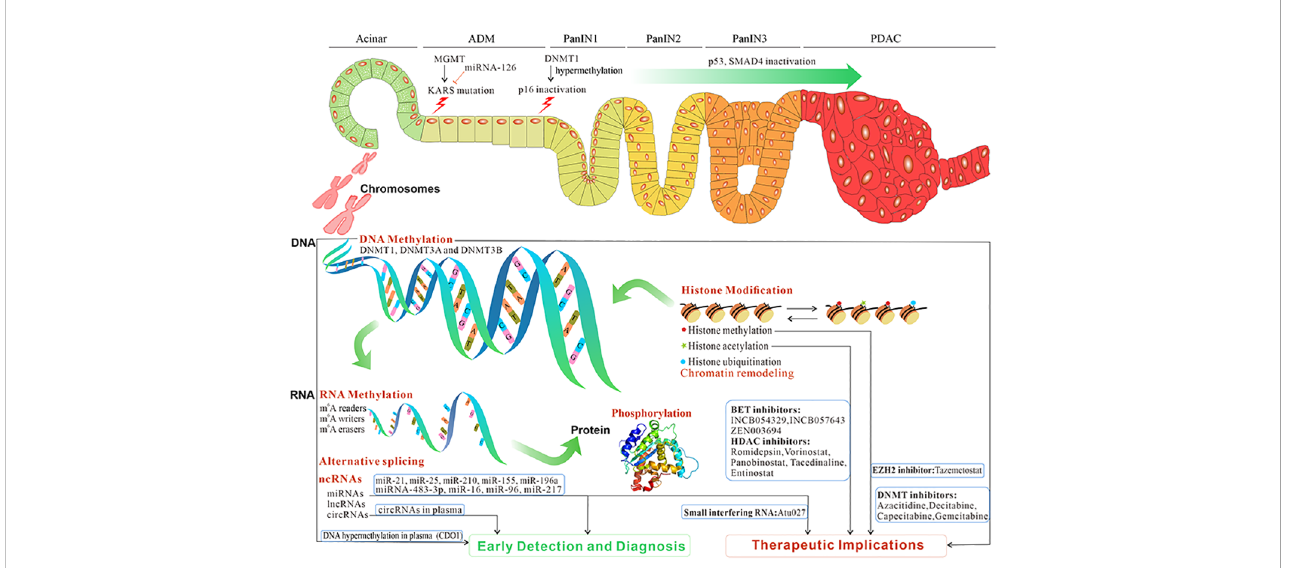
FIGURE 1 The overview and clinical implications of epigenetic reprogramming in pancreatic premalignancy and PC progression. Epigenetic reprogramming contributes to ADM, and its progression to PanIN and then PC. The initiation and progression of pancreatic premalignancy occur after epigenetic reprogramming such as DNA methylation, RNA methylation, microRNAs, lncRNAs, circRNAs, alternative splicing, histone modi fi cation, and phosphorylation. Those epigenetic changes potentially constitute biomarkers for early detection and diagnosis and targeted treatment in PC (data from ClinicalTrials.gov). PC, pancreatic cancer; ADM, acinar-to-ductal metaplasia; PanIN, pancreatic intraepithelial